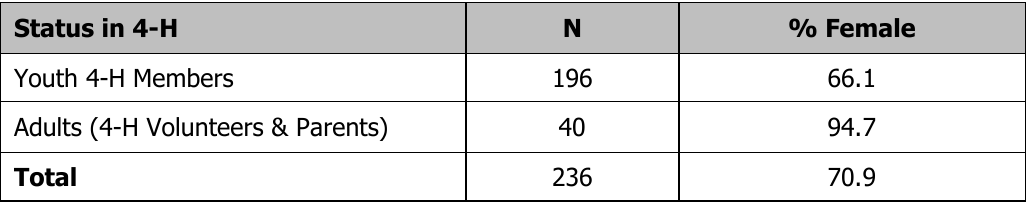
Online Record Book satisfaction survey